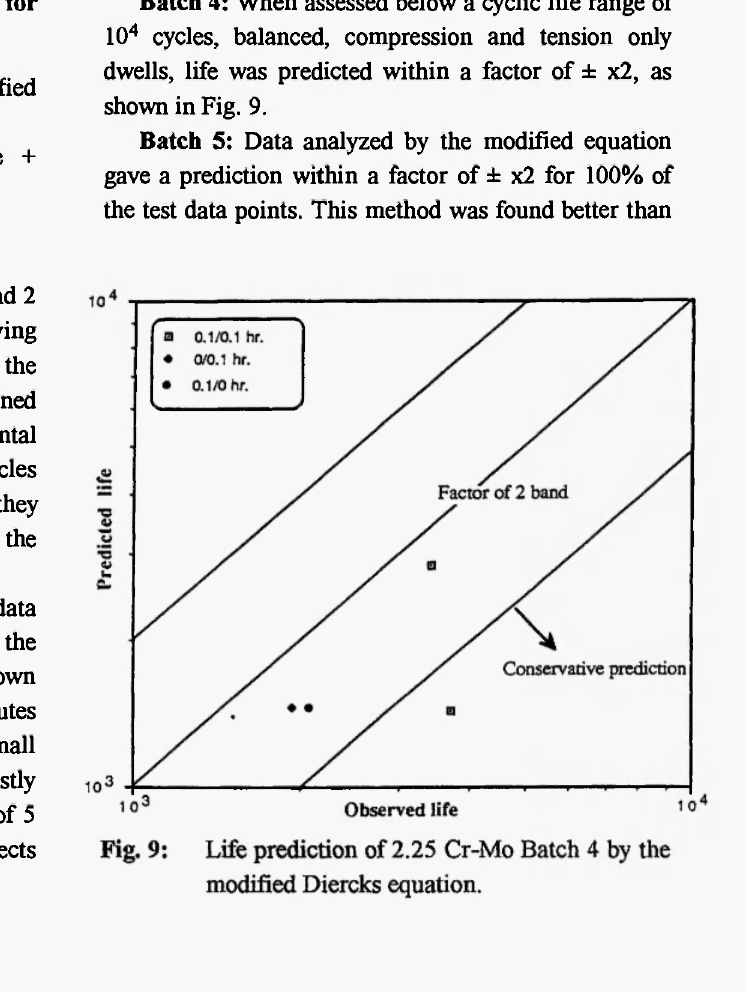
Fig. 8: Life prediction of 2.25 Cr-Mo Batch 3 by the modified Diercks equation. Batch 4: When assessed below a cyclic life range of 10 4 cycles, balanced, compression and tension only dwells, life was predicted within a factor of ± x2, as shown in Fig. 9. Batch 5: Data analyzed by the modified equation gave a prediction within a factor of ± x2 for 100% of the test data points. This method was found better